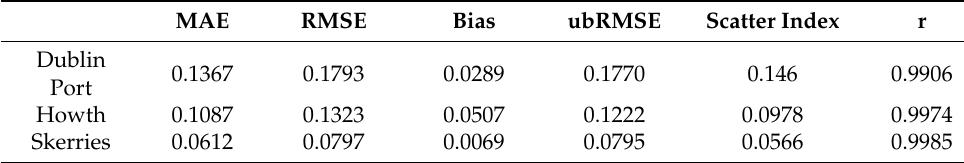
Table 1. Error metrics for Dublin Port, Howth and Skerries tide gauges. The model was calibrated and validated during the same period 1 December 2013–12 December 2013. MAE: mean absolute error; RMSE: root mean square error; ubRMSe: unbiased RMSE; r: Pearson’s Correlation Coefficient. MAE RMSE Bias ubRMSE Scatter Index r Dublin 0.1367 0.1793 0.0289 0.1770 0.146 0.9906 Port Howth 0.1087 0.1323 0.0507 0.1222 0.0978 0.9974 Skerries 0.0612 0.0797 0.0069 0.0566